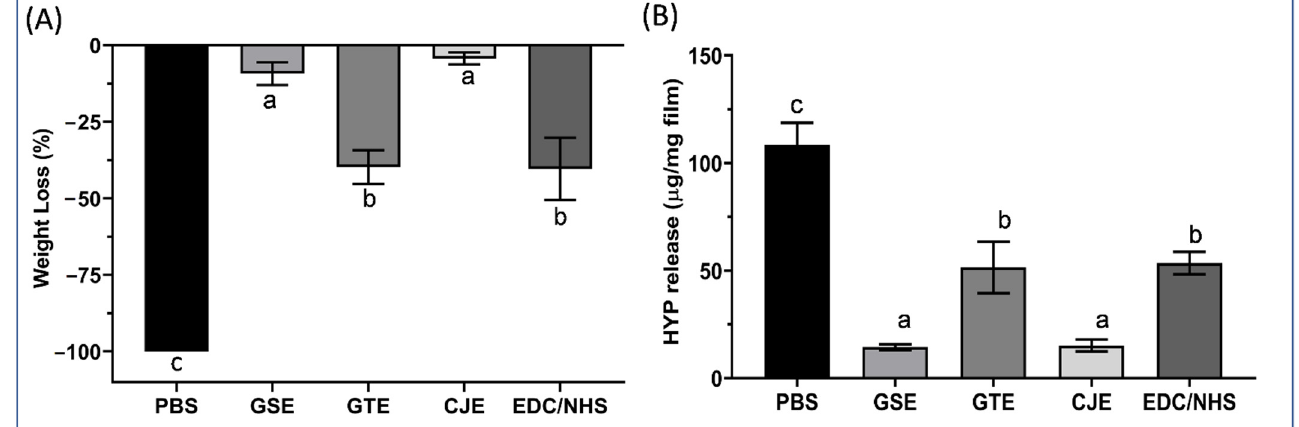
Figure 2. ( A ) Percent weight loss of the untreated PBS control and cross-linker-treated (for 30 s) demineralized dentin films after digestion with 0.1% collagenase solution for 1 h. Means with different letters are significantly different ( p < 0.05). ( B ) Hydroxyproline (HYP) release content of the untreated PBS control and cross-linker-treated (for 30 s) demineralized dentin films after digestion with 0.1% collagenase solution for 1 h. Means with different letters are significantly different ( p < 0.05). PBS: phosphate buffered saline. GSE: grape seed extract. GTE: green tea extract. CJE: cranberry juice extract. EDC/NHS: carbodiimide/n-hydroxysuccinimide.